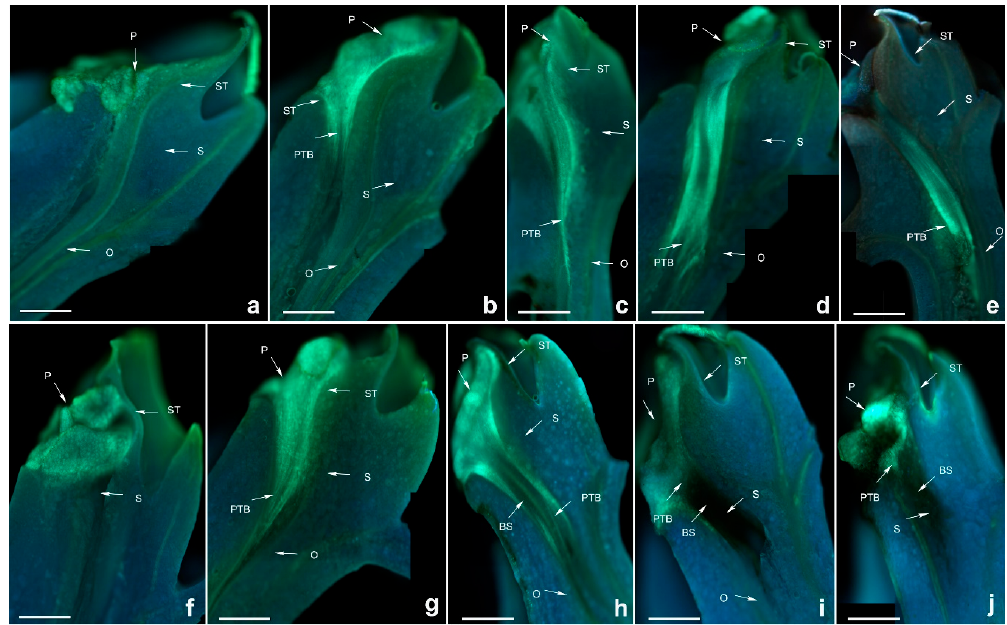
Figure 8. Growth of pollen tubes after self- and cross-pollination of Dendrobium hancockii . P: pollinium;